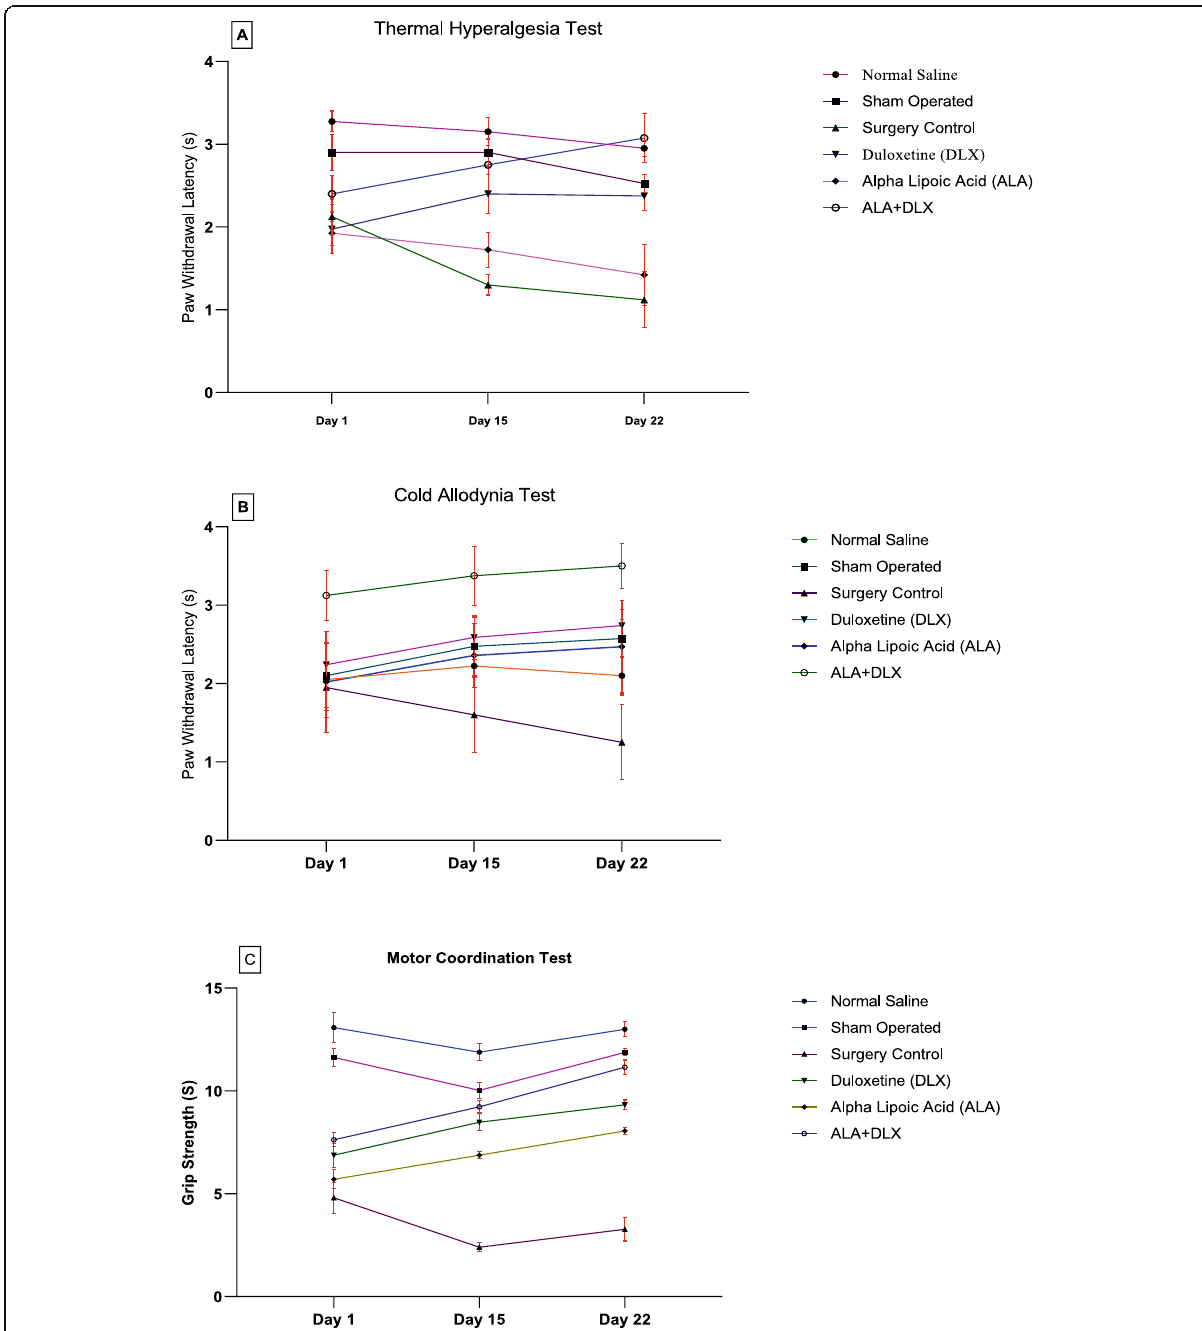
Fig. 2 Effect of ALA (25 mg/kg/i.p), DLX (30 mg/kg/p.o), Combination (ALA + DLX) (25 mg/kg; IP,30 mg/kg/p.o) on total protein levels, tissue glutathione levels, tissue nitric oxide and tissue MDA levels. Data expressed as mean ± SEM ( n = 3) rats per group, analysed by two-way ANOVA followed by Tukey ’ s multiple comparisons test. p < 0.05 (*), p < 0.01 (**), p < 0.001